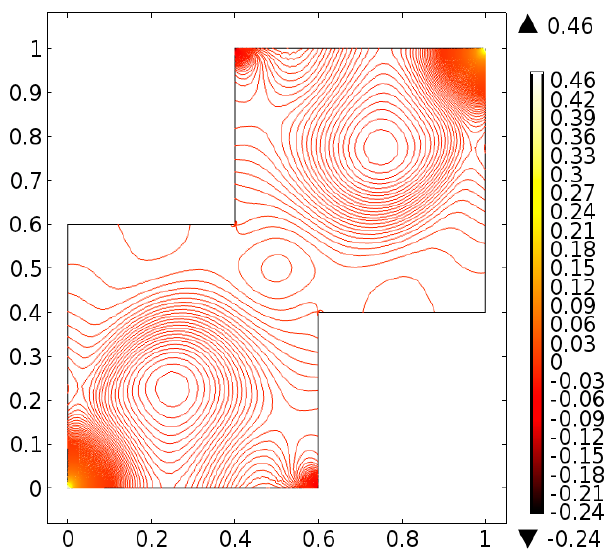
Figure 38. Pressure distribution at Re = 1000 for case-III.